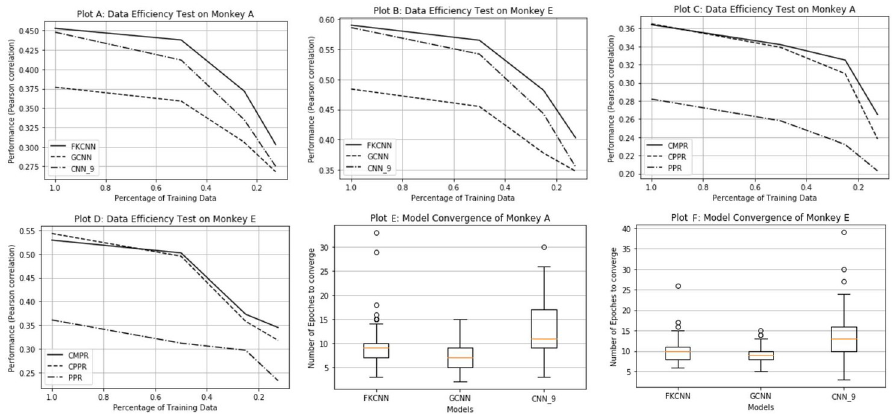
Fig 9. Model data-efficiency and convergence test. Plots A, B, C and D show model performance as a function of the proportion of data used for each monkey and model type. Plots E and F summarize the distributions of training times (measured in epochs) across neurons for each model type and monkey in box-and-whisker plots. Please note that we did not compare the PPR, CPPR, and CMPR’s convergence rate because they each have different training procedures, which don’t allow fair